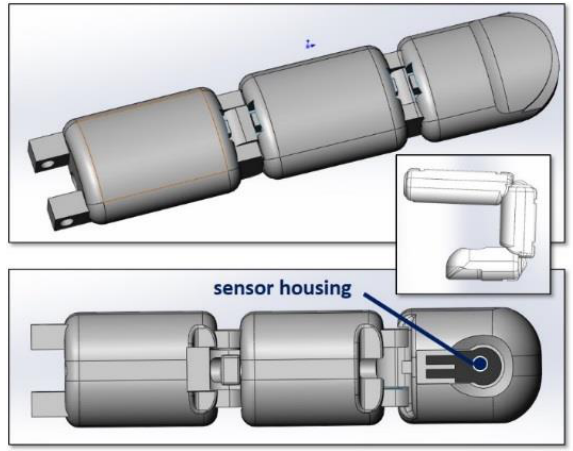
Figure 2. The anthropomorphic robotic finger and fingertip sensor housing.